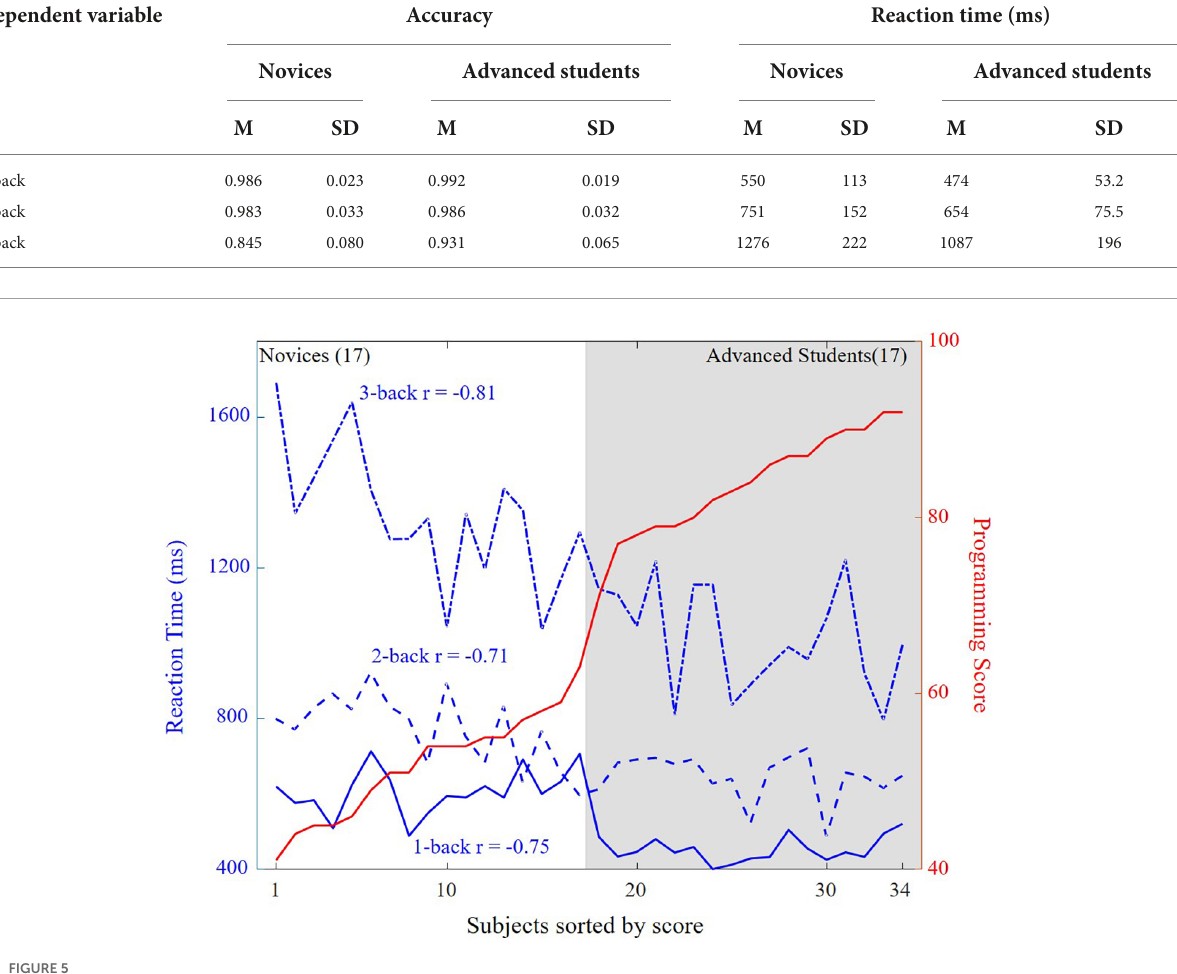
TABLE 1 Means and standard deviations of accuracy and reaction time during the n-back task.